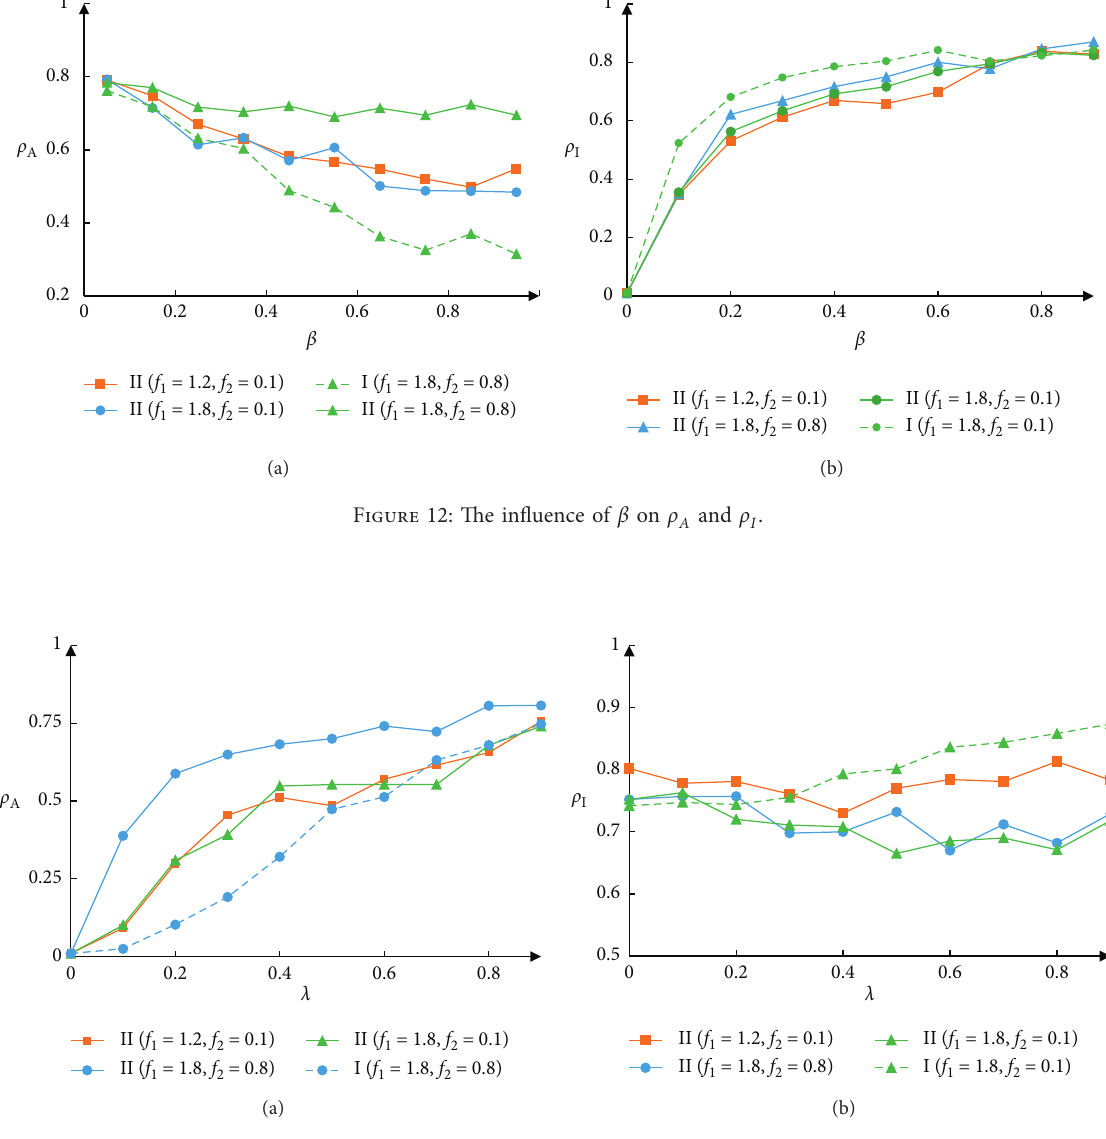
Figure 13: The influence of λ on ρ